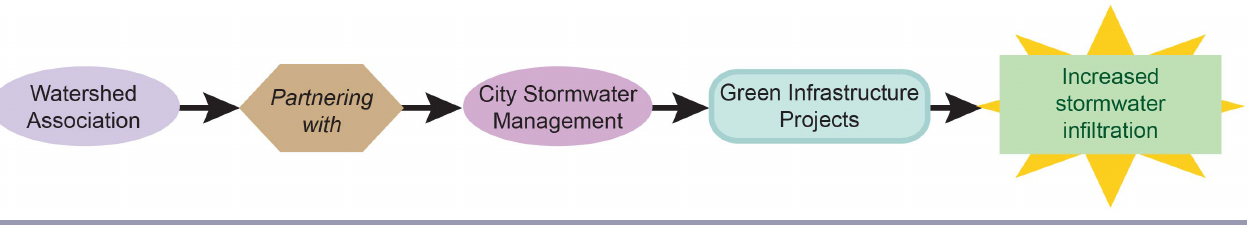
Fig. 1 . Example showing how a project manager’s description of an ongoing project was represented graphically as problem-relevant system elements (polygons) linked to each other (arrows) emphasizing how actions and/or events link to outcomes. Several of these short summaries are produced during each interview and are the building blocks for a conceptual